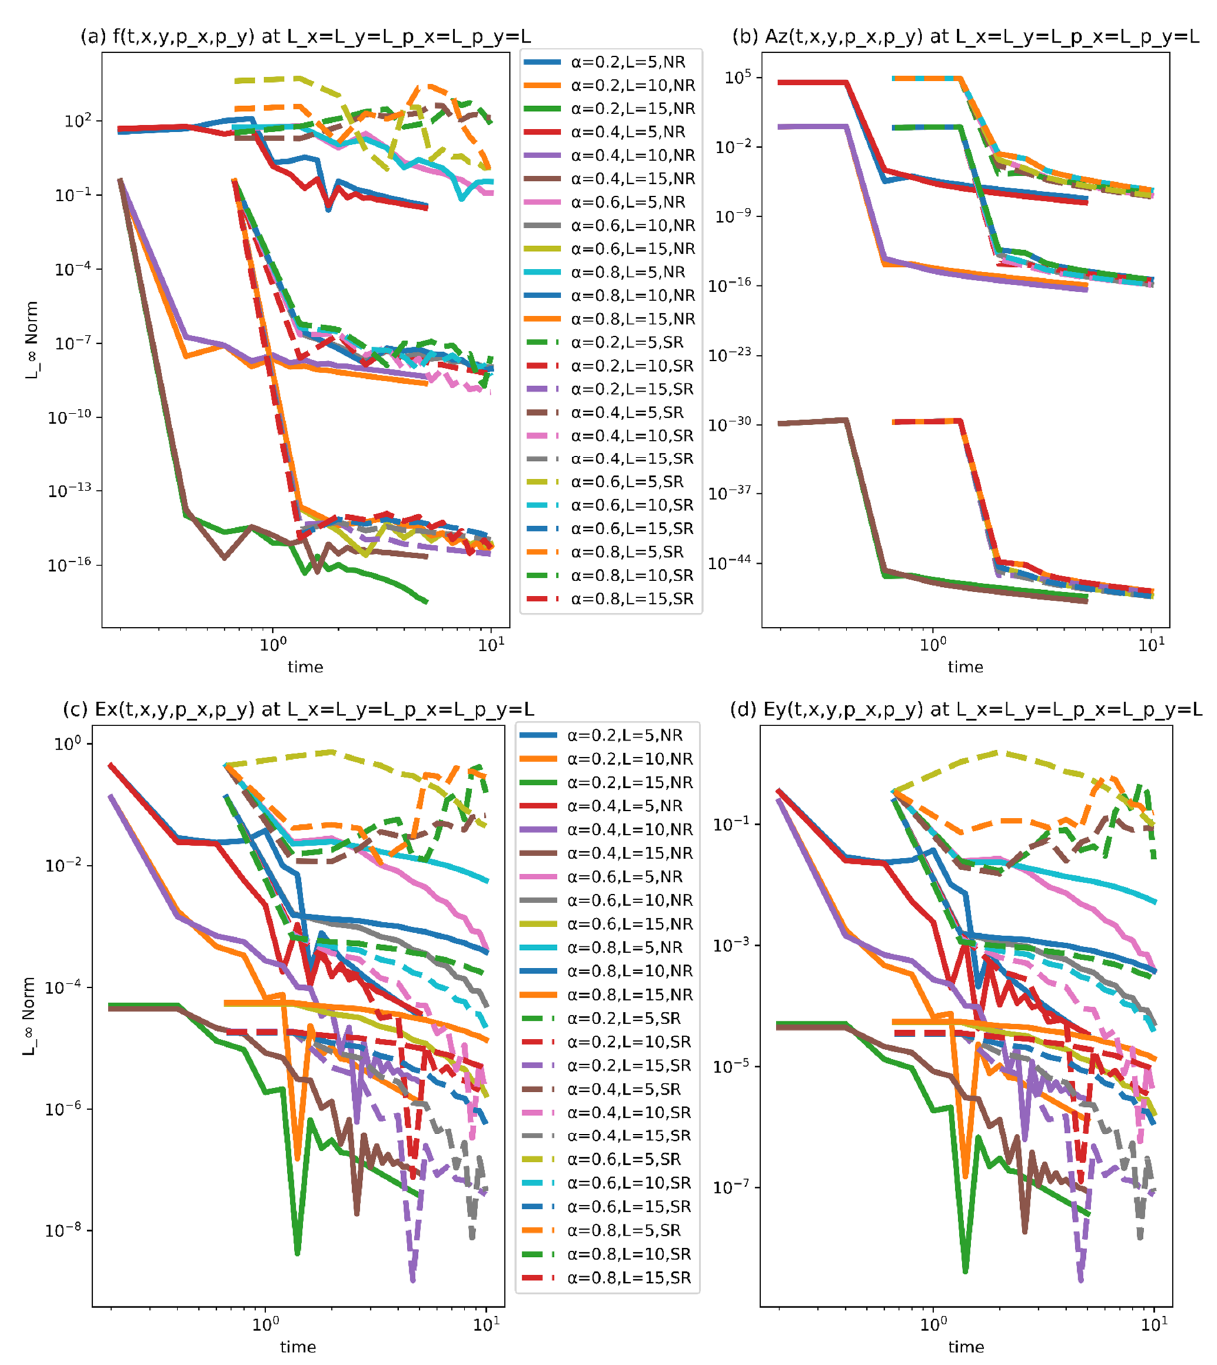
Figure 6. ( a – d ) Convergence of norm at N = 1000, M